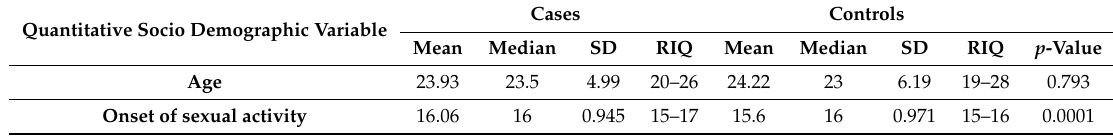
Table 4. Quantitative sociodemographic variables in cases (186) and controls (369).